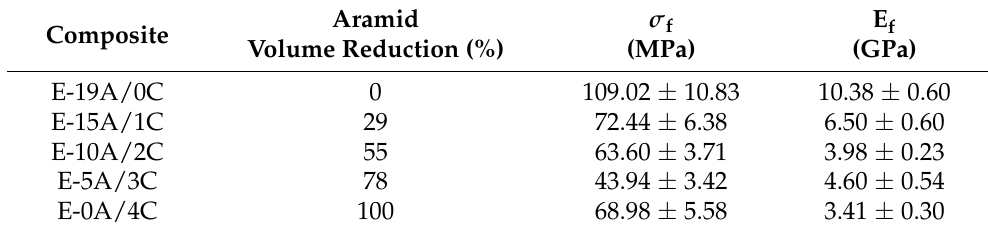
Table 4. Flexural properties of hybrid laminated